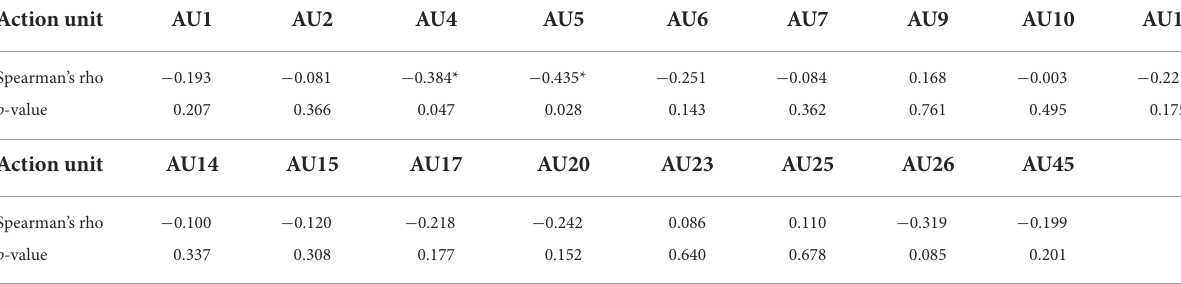
TABLE 7 Spearman’s correlations r (20) with users’ ratings to DC item